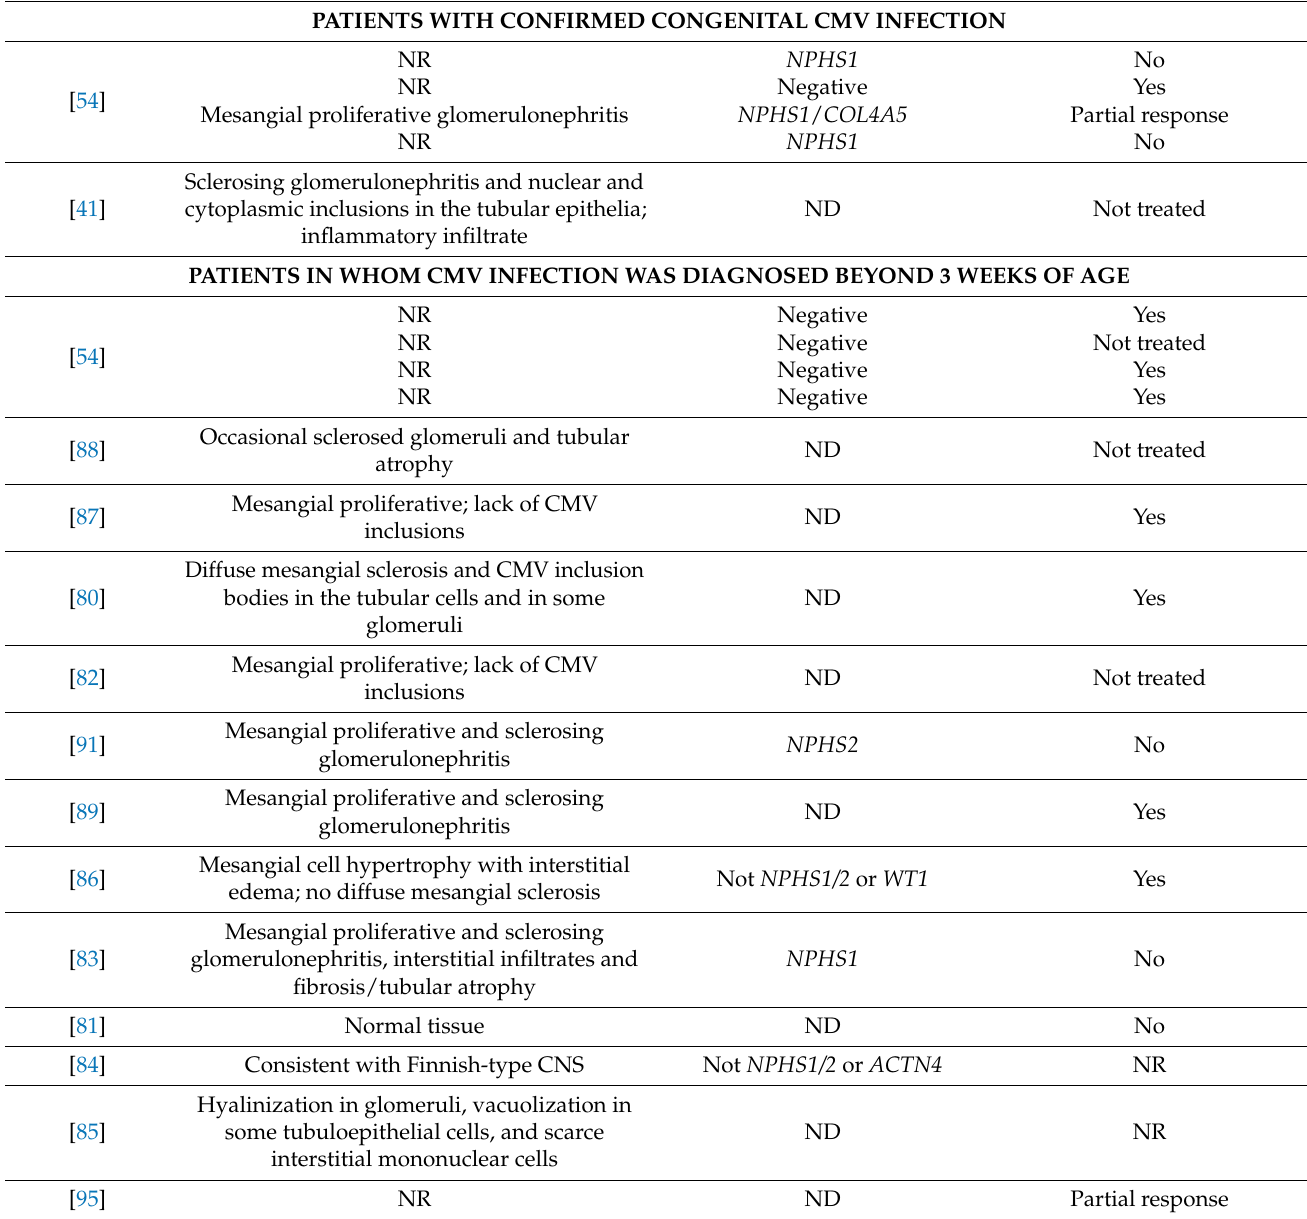
Table 5. Details of patients diagnosed with concomitant congenital nephrotic syndrome and CMV infection. Ref. Kidney Histopathological Findings Genetic Study Response to Antivirals